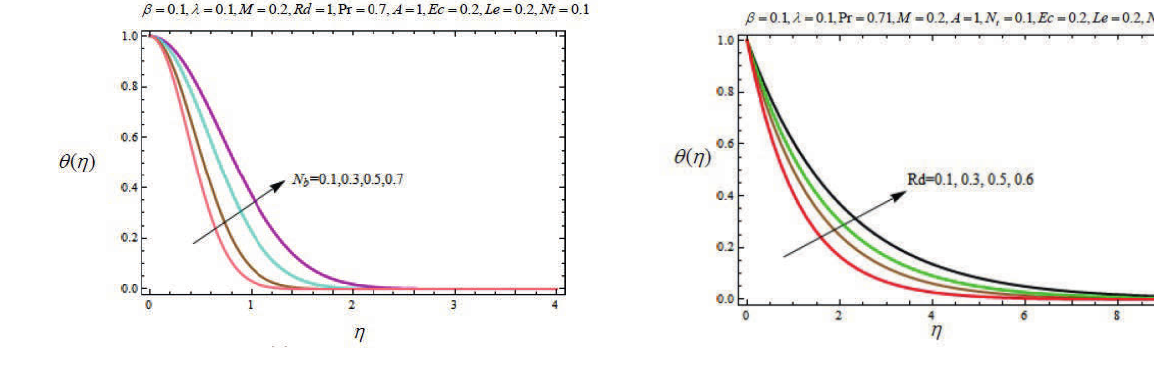
Fig. 12: Variation of temperature profile θ ( η ) with η for several val- ues of radiation parameter R d .